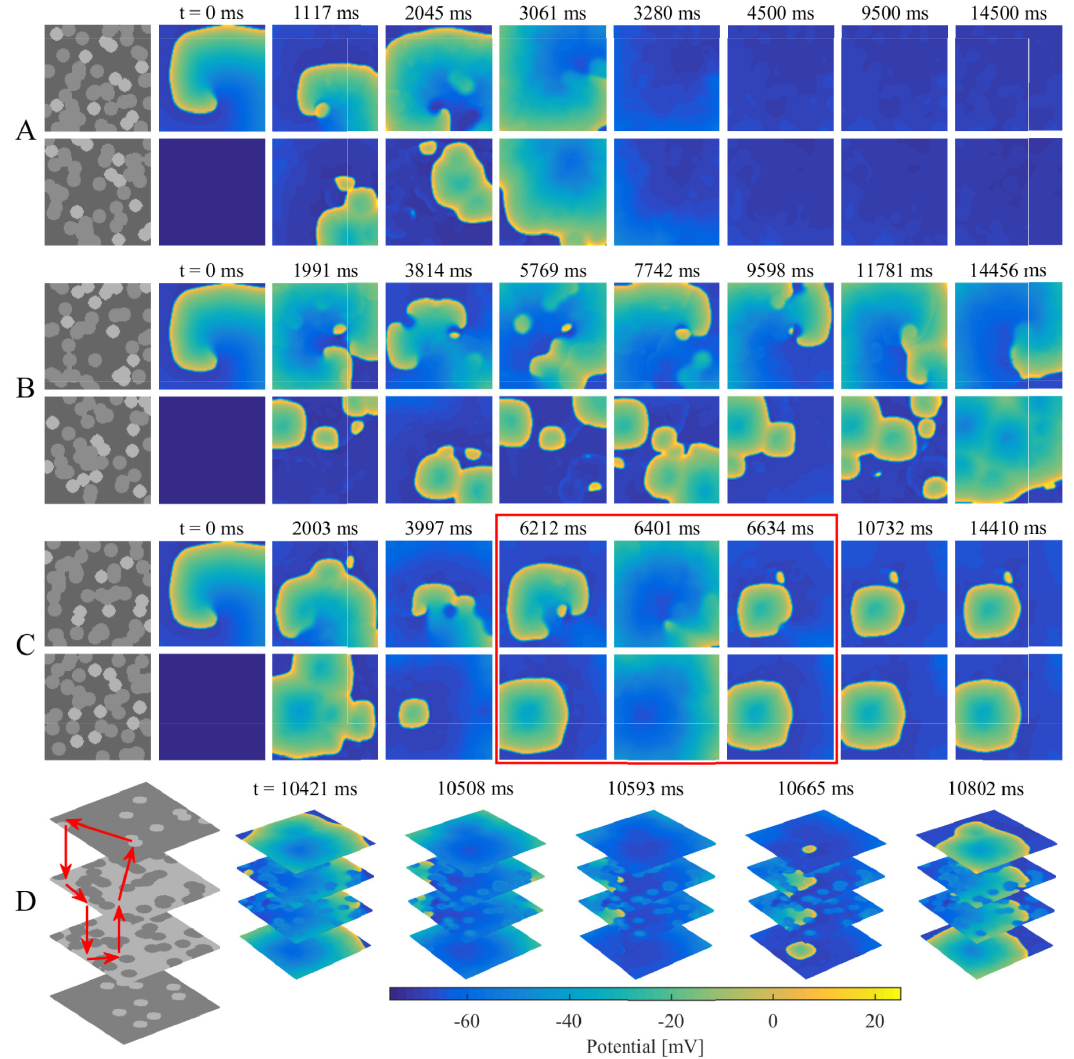
Fig 5. Examples demonstrating three different categories of transmembrane potential maps in the stochastic group. (A) A non- stable disorder with the rotor center of spiral wave moving away from the endocardium sheet after colliding with breakthroughs. (B) A stable disorder with spiral waves sustaining on the endocardium sheet even with collisions of breakthroughs. (C) A stable disorder maintaining with an intramural re-entry after spiral wave disappearing during collisions of breakthroughs as shown in the red box. (D) Circuit diagram of the intramural re-entry in (C). Red arrows denote the loop lines of intramural re-entry.